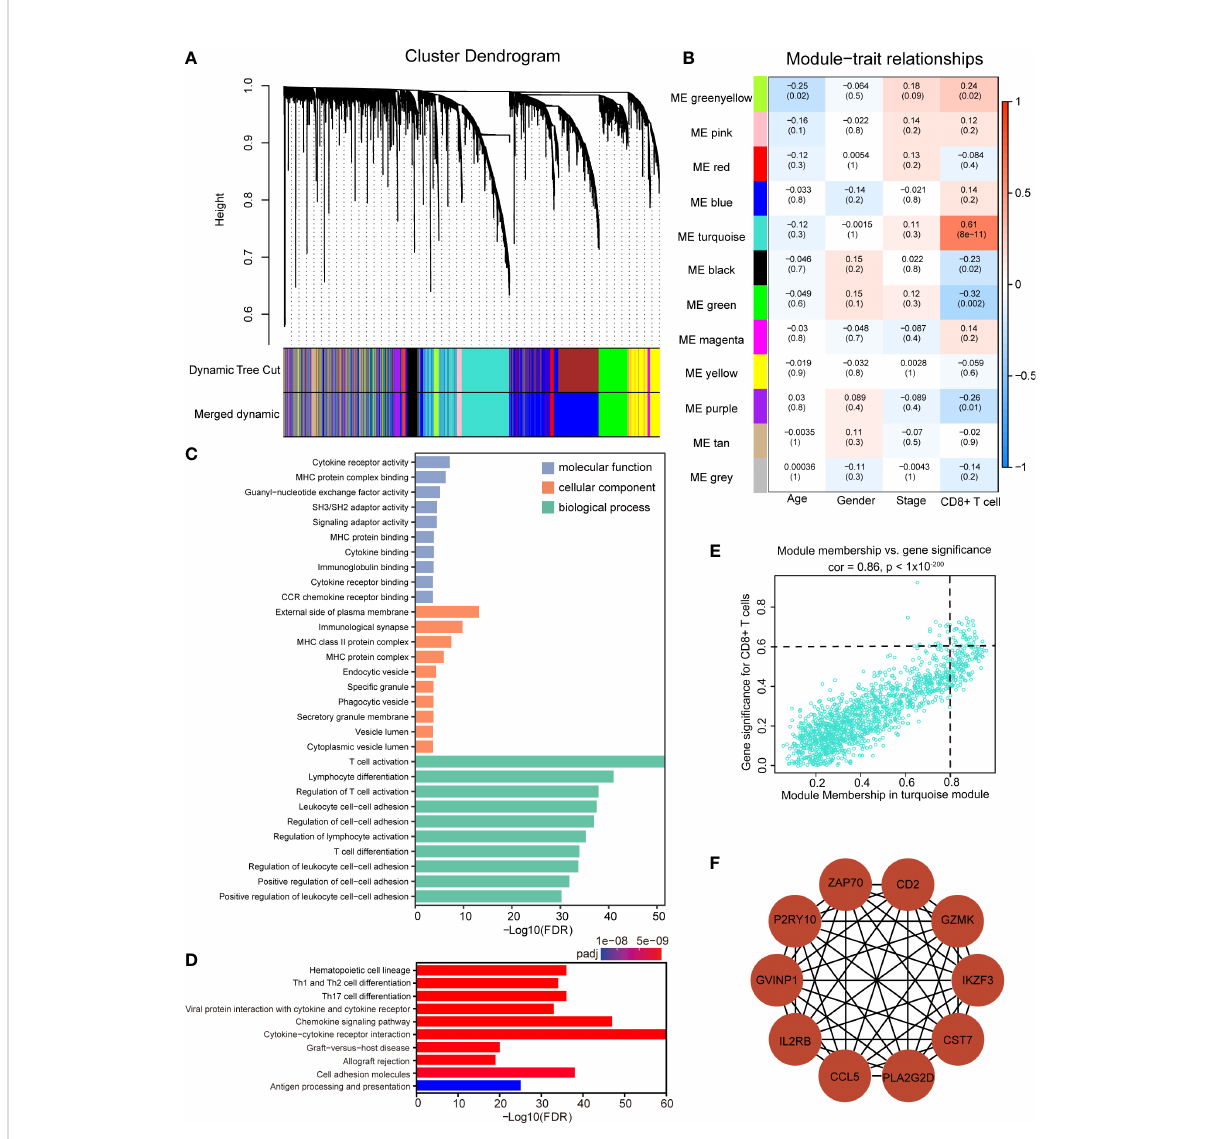
FIGURE 5 Identi fi cation of signi fi cant modules and Hub genes via WGCNA. (A) Gene dendrogram obtained by average linkage hierarchical clustering. The color row underneath the dendrogram indicates 12 different coexpression gene modules (the grey module represents unassigned genes. (B) The module – trait relationship heatmap between module eigengenes (row) and clinical traits (column). The correlation coef fi cients and p values are annotated in each box. (C, D) GO analysis (C) and KEGG pathway enrichment analysis (D) of all genes in the turquoise module. (E) Scatter plot of gene signi fi cance for the in fi ltration of CD8+ T cells (y axis) versus module membership (x axis) in the turquoise module. (F) Protein – protein interaction network of the ten Hub